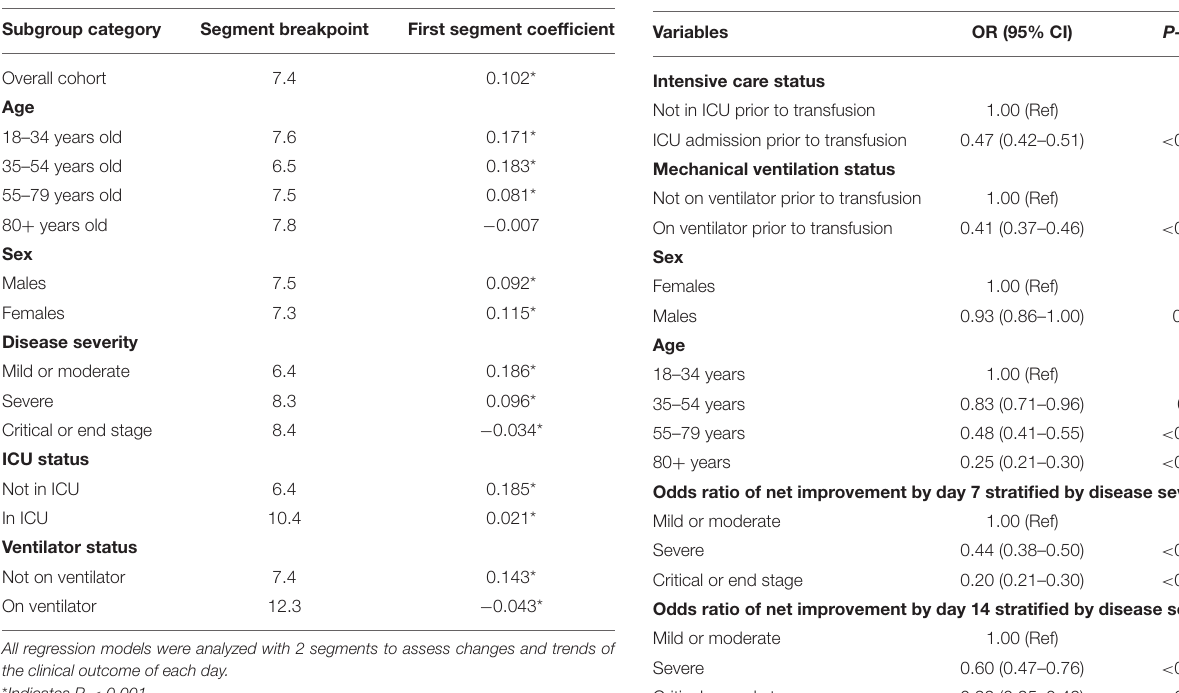
TABLE 2 | Segment breakpoints in first segment coefficient by patient characteristics.